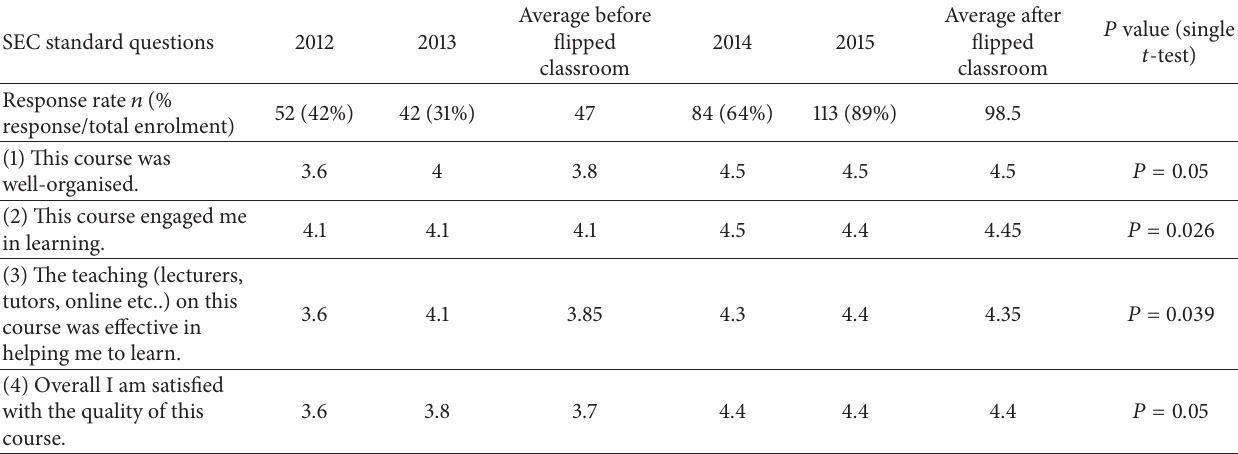
Table 3: Showing a summary of the SEC standard questions results obtained over the period of the study before and after using the flipped classroom method.